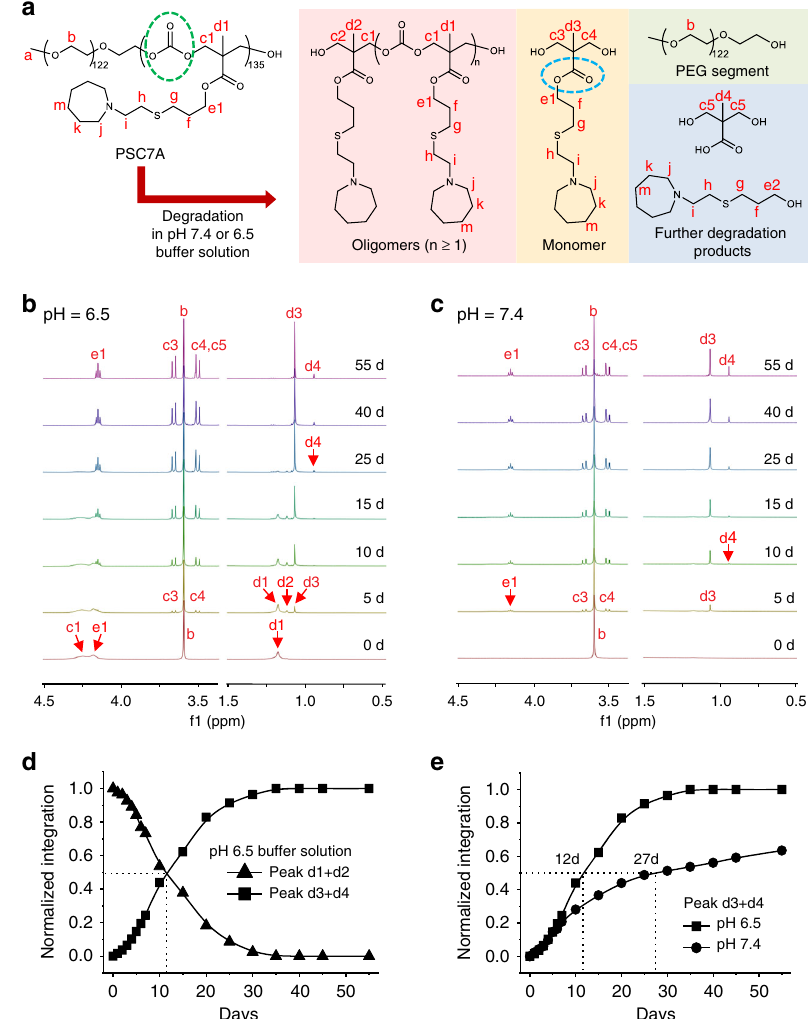
Fig. 5 Degradation studies of PSC7A copolymer in deuterated buffer solutions at pH 6.5 and 7.4. a Chemical structures of PSC7A and its degraded products. 1 H NMR spectra of the degradation of PSC7A in b pH 6.5 and c pH 7.4 deuterated buffer solutions over time. Proton signal of PEO segment was used as an internal reference. Only selected regions of the spectra are presented for clarity, see the complete spectra in Supplementary Figs. 16 and 17. d Normalized integration ratios of peaks (d1 + d2), and peaks (d3 + d4), relative to normalized proton signal of the PEO segment in pH 6.5 deuterated buffer solution. e Integration ratios of peaks (d3 + d4) relative to normalized proton signal of the PEO segment in pH 6.5 and 7.4 deuterated buffer